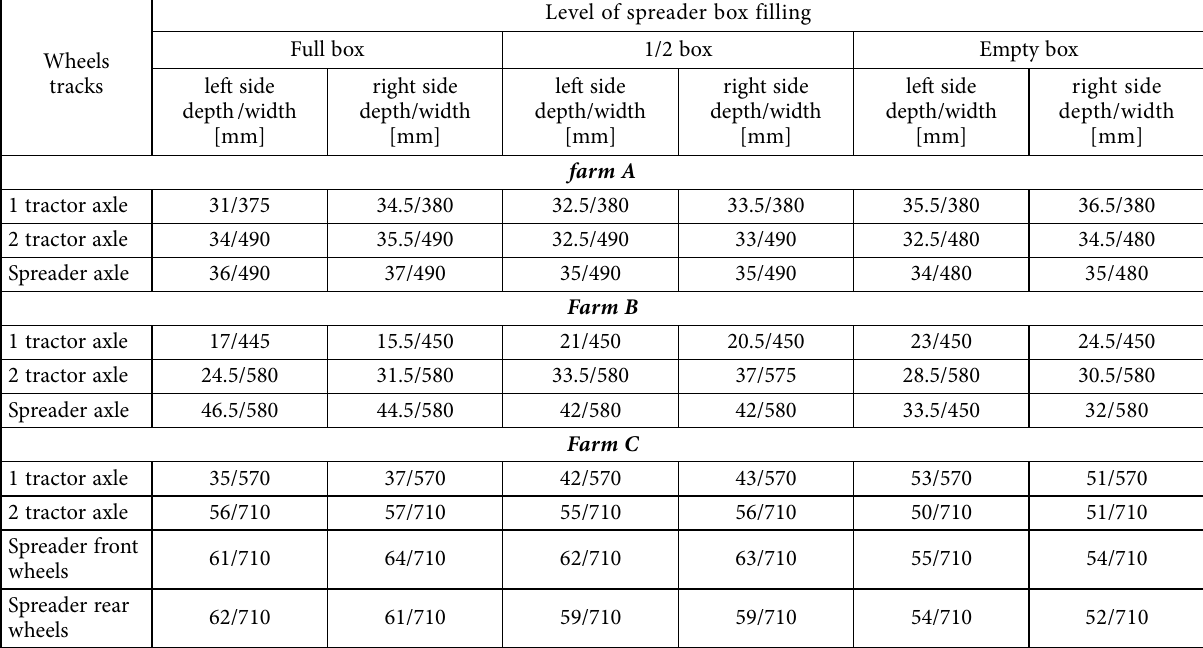
Table 9. Results of measurements of tracks’ width and depth